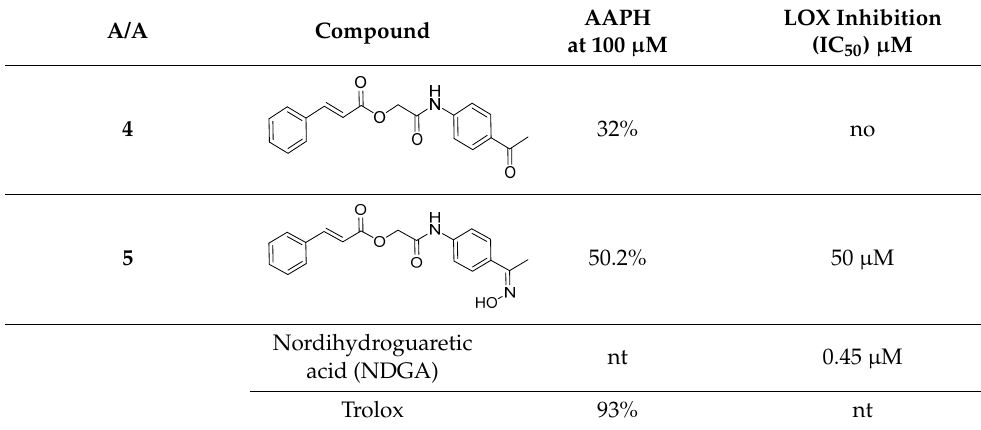
Table 2. Inhibition of AAPH-induced lipid peroxidation (LP%) and soybean LOX (IC 50 ). A/A